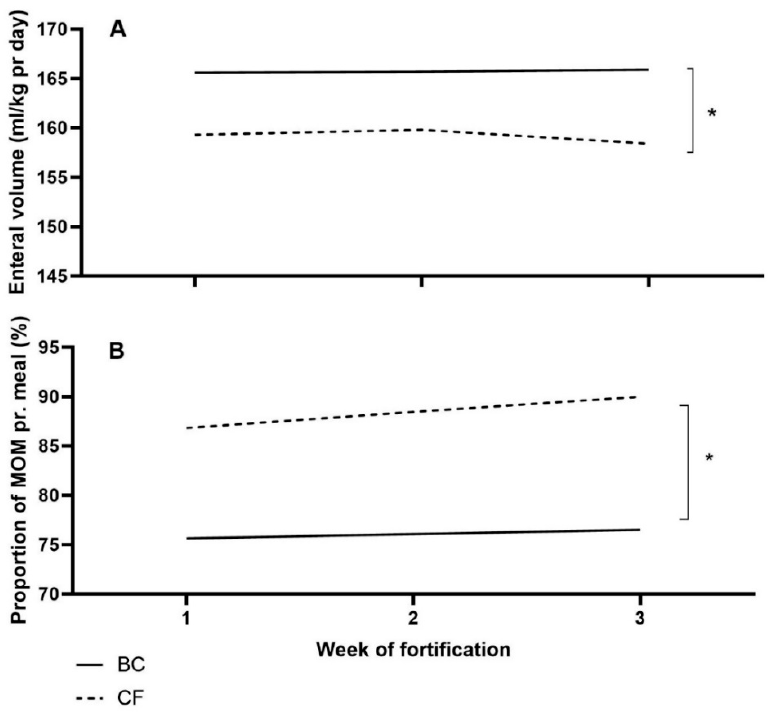
Figure 2. Mean volume of enteral nutrition per kg pr. day ( A ), and the proportion of the mother’s own milk (MOM) per meal ( B ) for Bovine colostrum (BC) and Conventional fortifier (CF). pr.: per. * p <